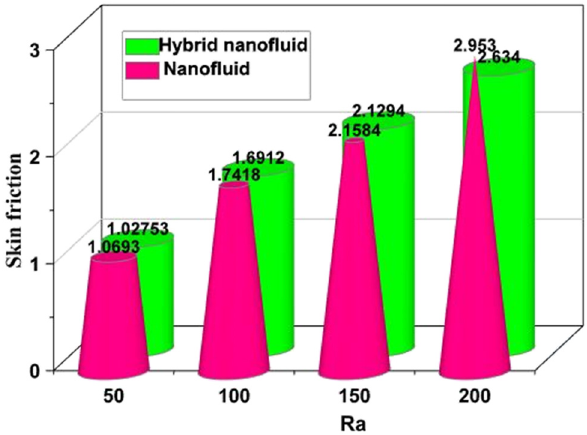
Figure 5: Skin friction versus